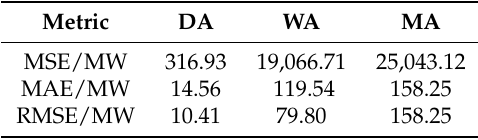
Table 1. The comparison of average load prediction.